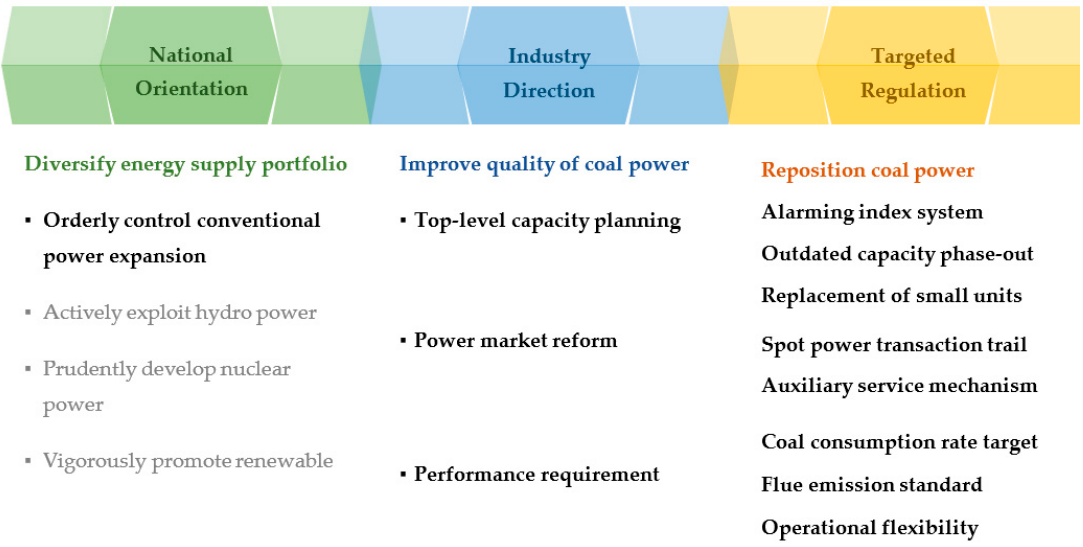
Figure 3. China’s macro-energy policies and coal power guidance for the past two decades.